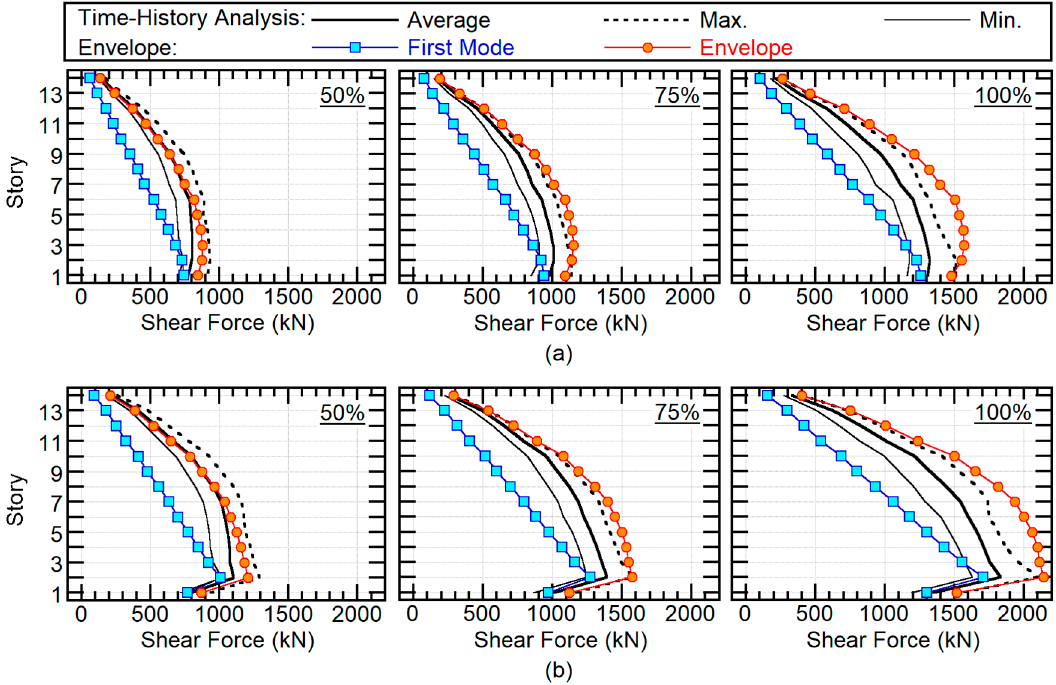
Figure 15. Comparisons between maximum shear forces of vertical members (Art-L series): ( a ) column X 2 Y 1 and ( b ) column X 2 Y 2 (with spandrel walls).